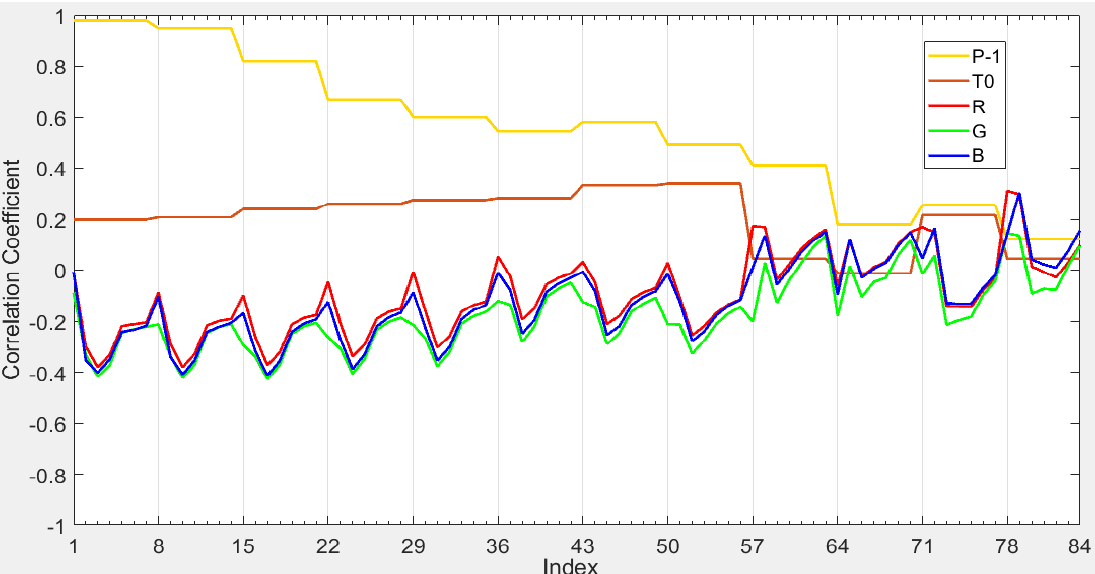
Figure 8. Correlation between P 0 and the evaluated variables. Figure 9. Correlation between ∆ P and the evaluated Figure 9. Correlation between Δ P and the evaluated variables.